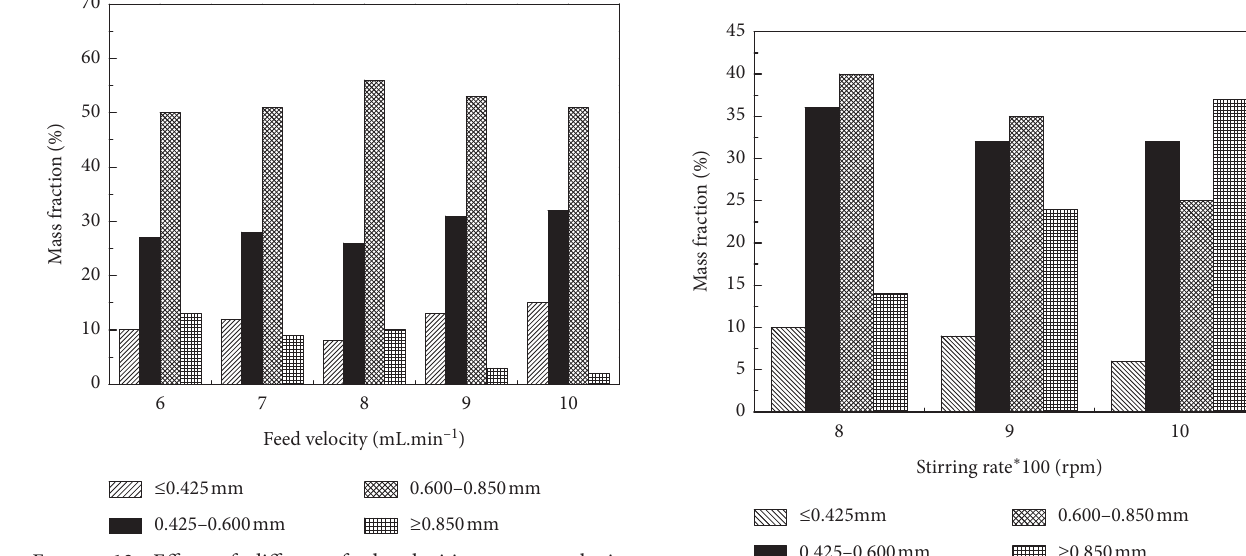
Figure 12: Effect of different feed velocities on crystal size distribution. Table 6: C.V. of the product with different feed velocities. Feed velocity (mL.min − 1 )